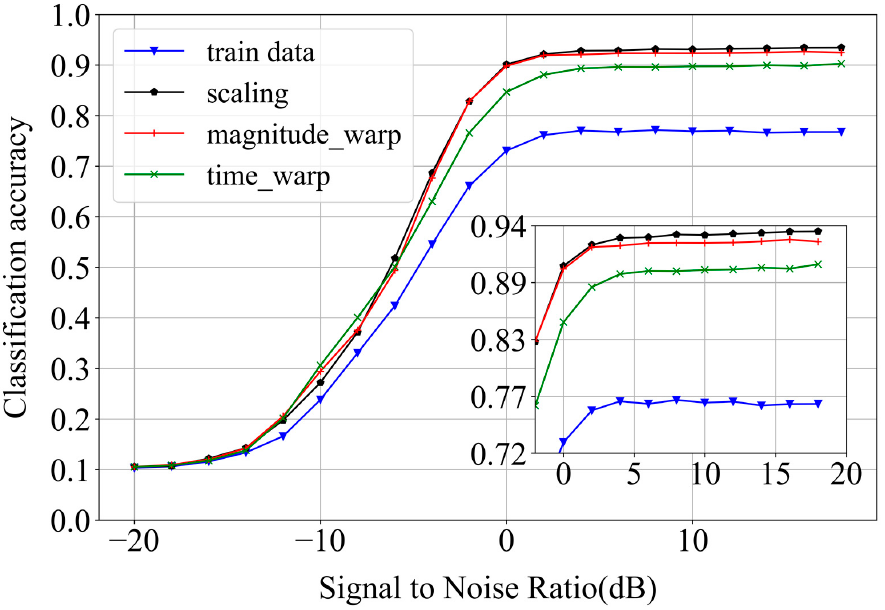
Figure 6. Recognition accuracy of three data augmentation methods under different SNRs.